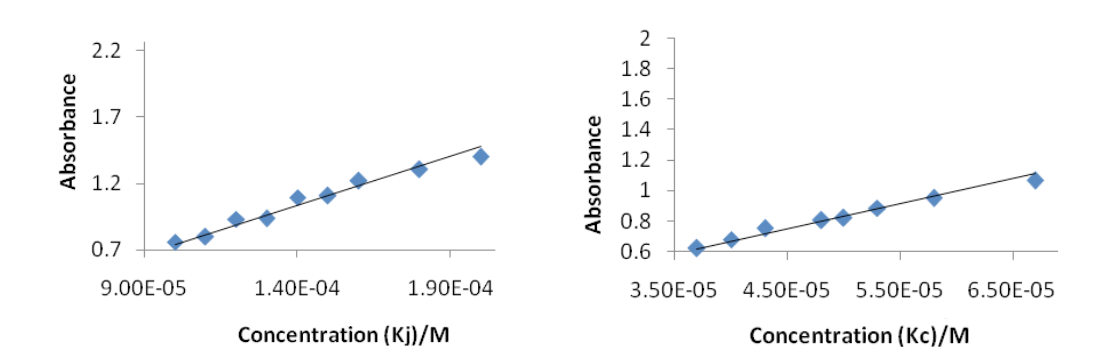
Figure 1. Concentration profile of karanjin (Kj) and karanjachromene (Kc).